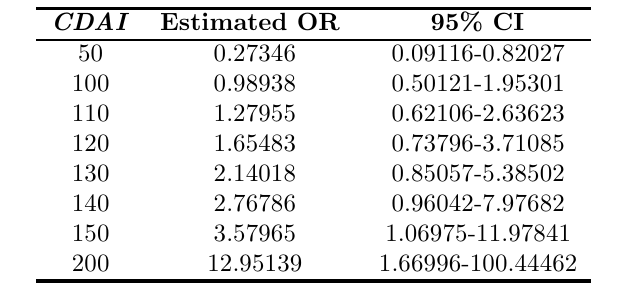
Estimated Odds Ratios (OR), with 95% confidence limits, for DIS LOC as a function of CDAI CDAI Estimated OR